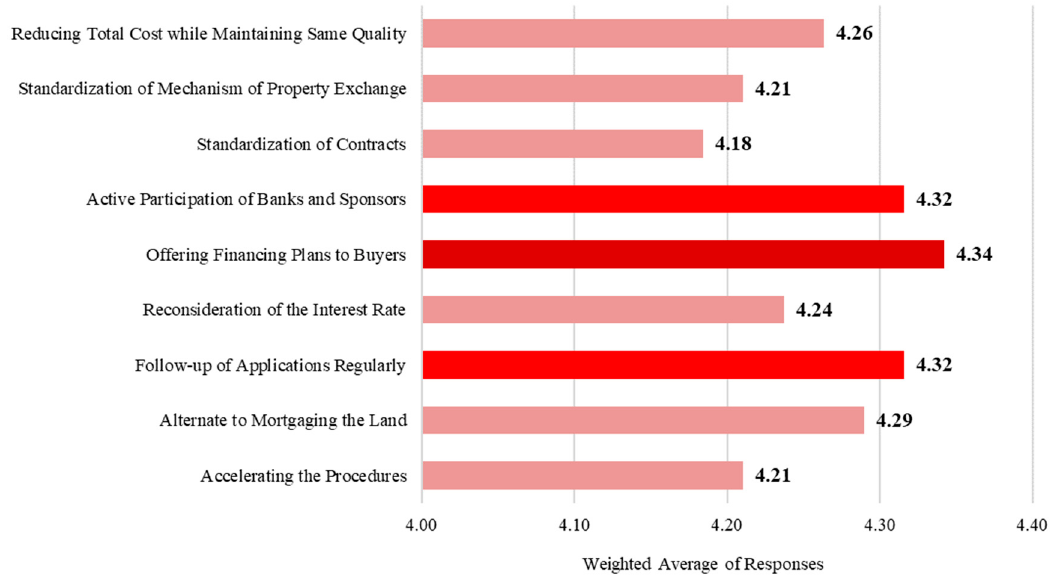
Figure 12. Consensus-Based Financial Measures as Proposed by Experts.